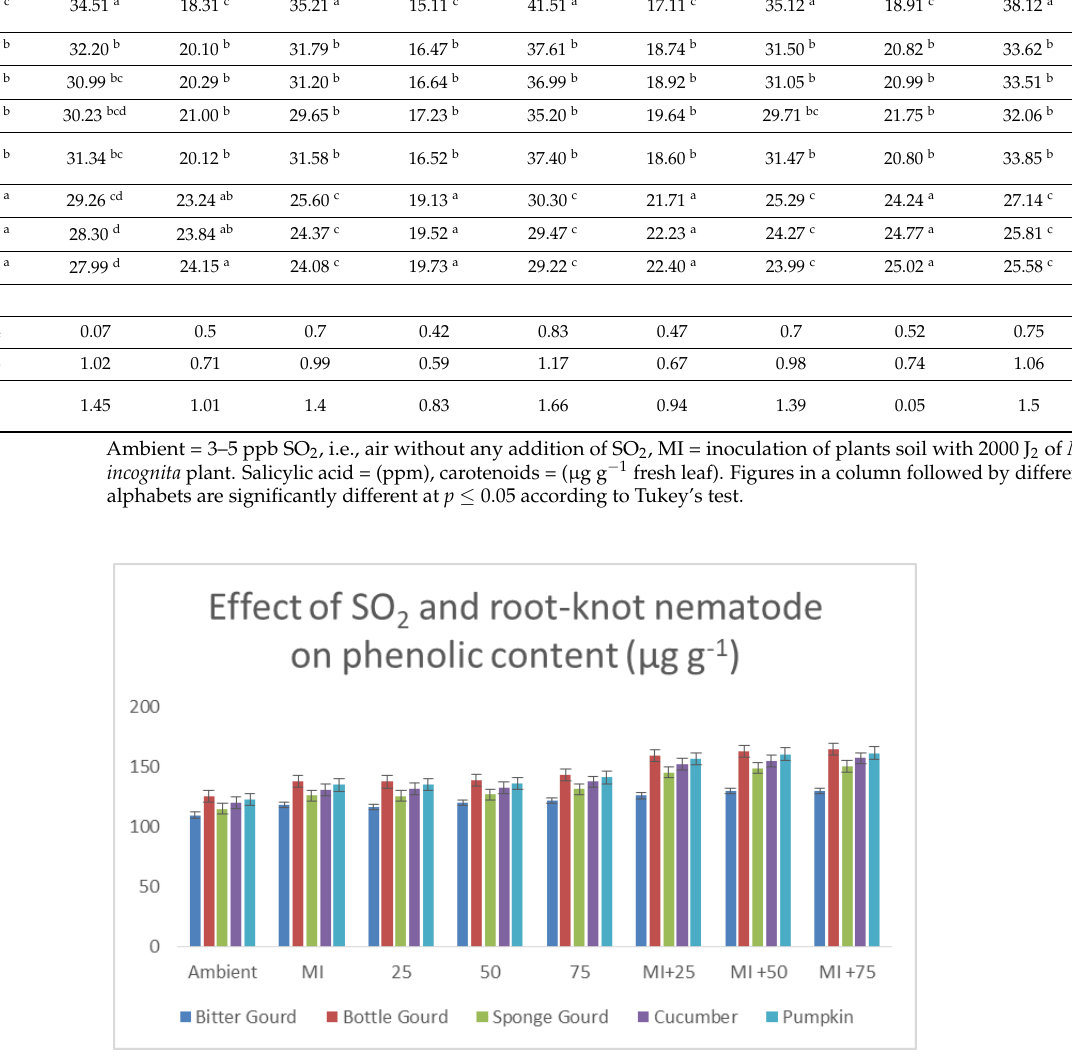
Figure 8. Bar diagram showing the effect of SO 2 exposure and root-knot nematode on the total phenolic content of leaves of five cucurbits.